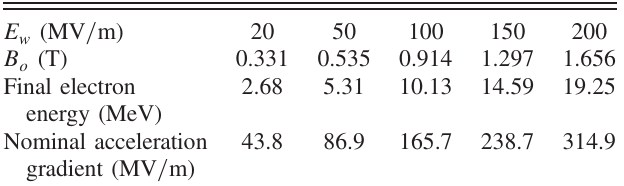
TABLE II. Parameters for Fig.